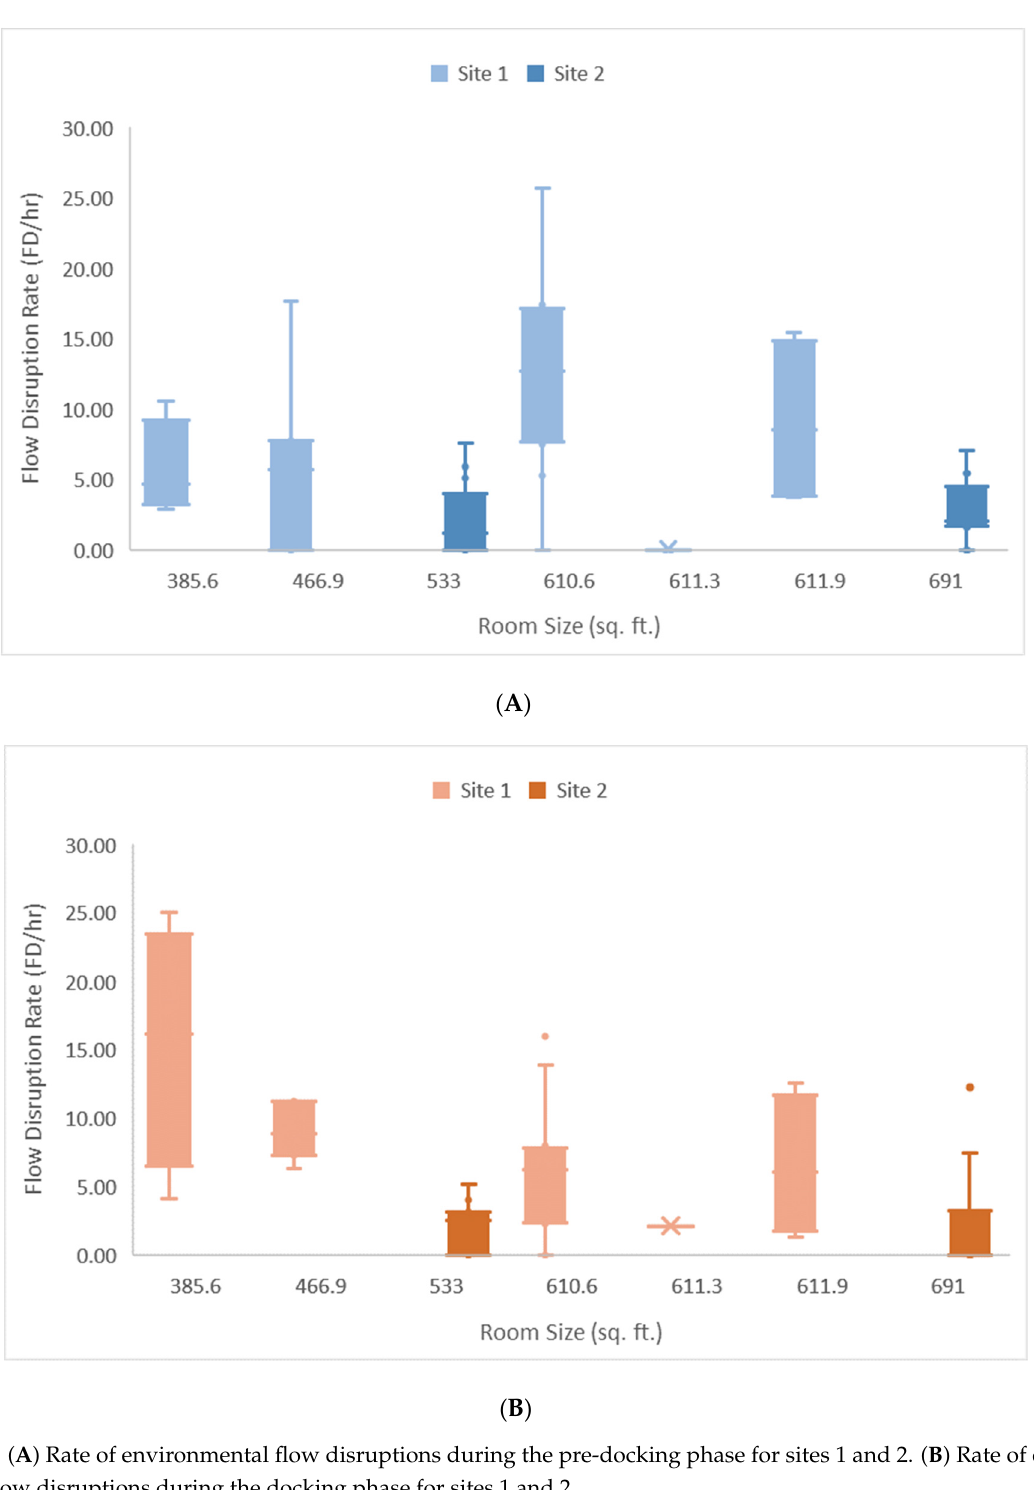
Figure 3. ( A ) Rate of environmental flow disruptions during the pre-docking phase for sites 1 and 2. ( B ) Rate of environ- mental flow disruptions during the docking phase for sites 1 and 2.